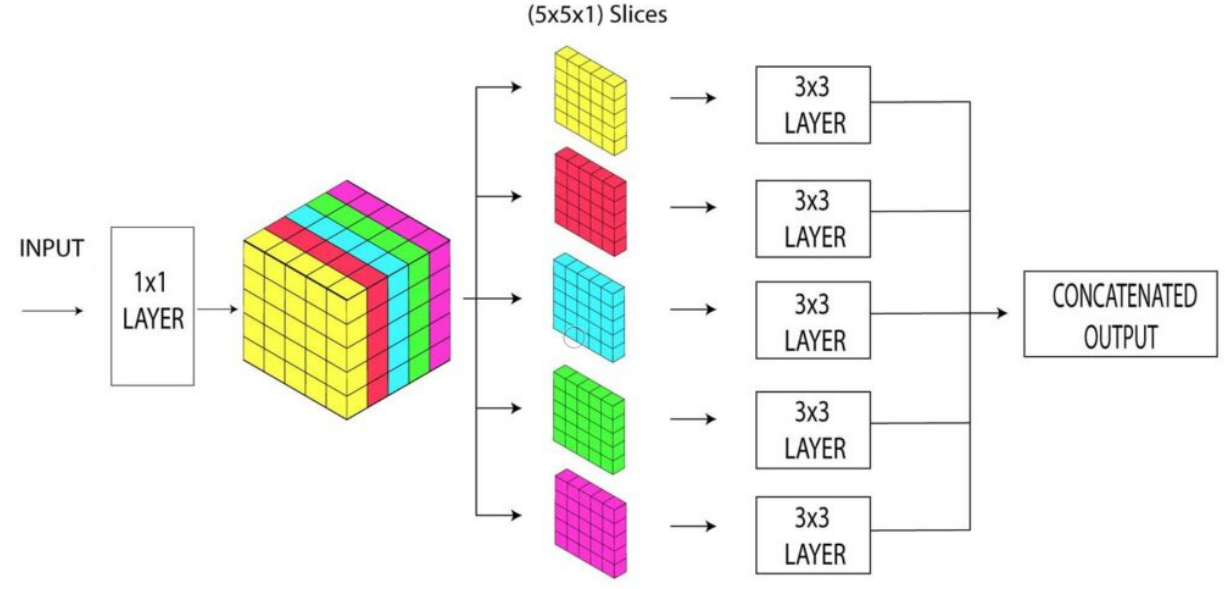
Figure 2. The architectures of the Xception model.